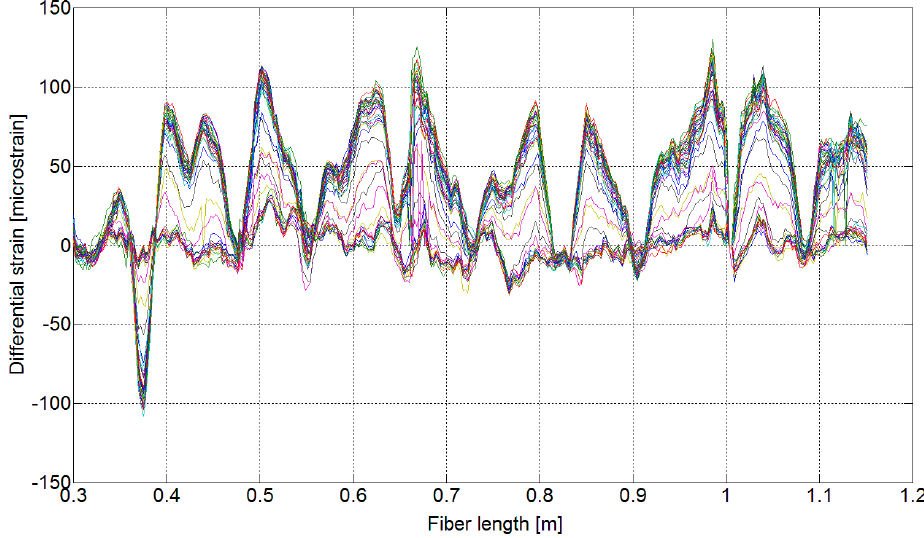
Figure 13. Dynamic differential strain acquisition after impact for PNL2.